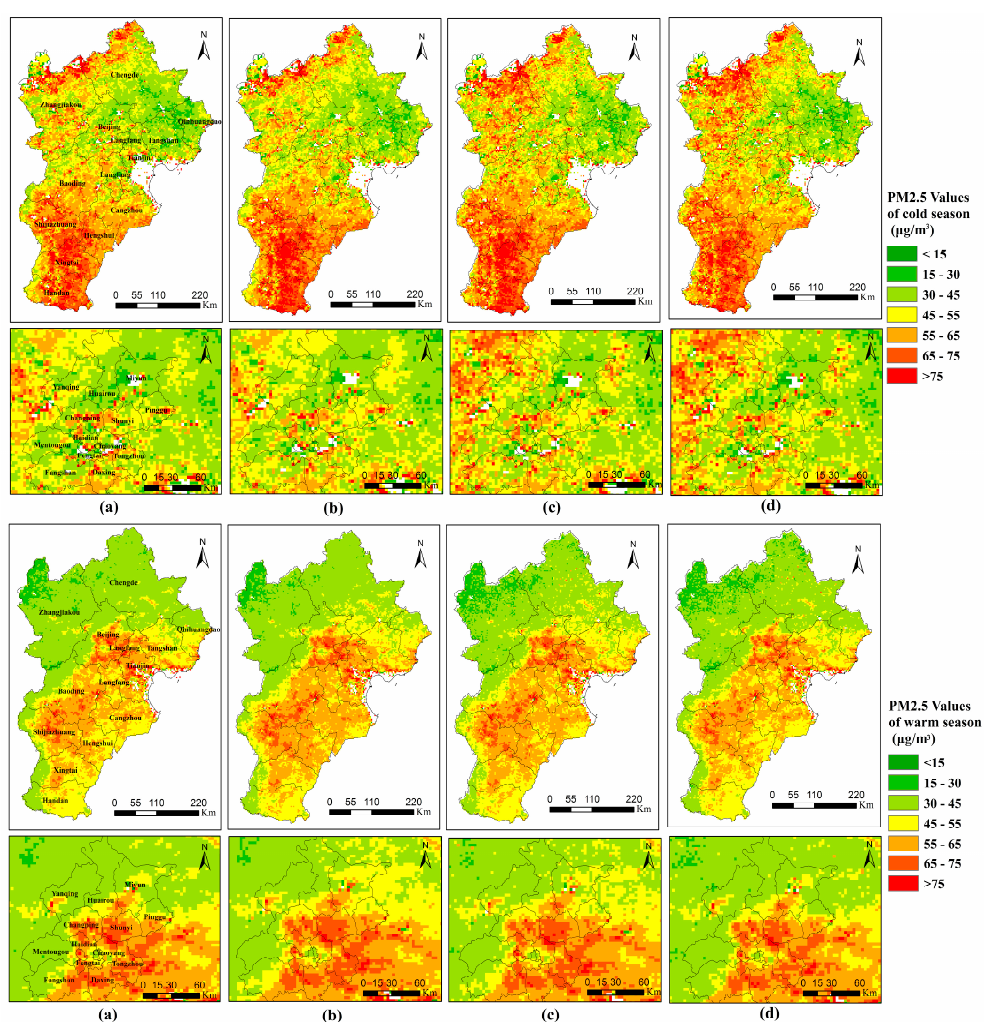
Figure 5. Spatial distributions of seasonal mean PM 2.5 estimations: cold season (upper) and warm season (lower): ( a ) Meteor_LME, ( b ) NDVI_LME, ( c ) NTL_LME, and ( d ) VANUI_LME.